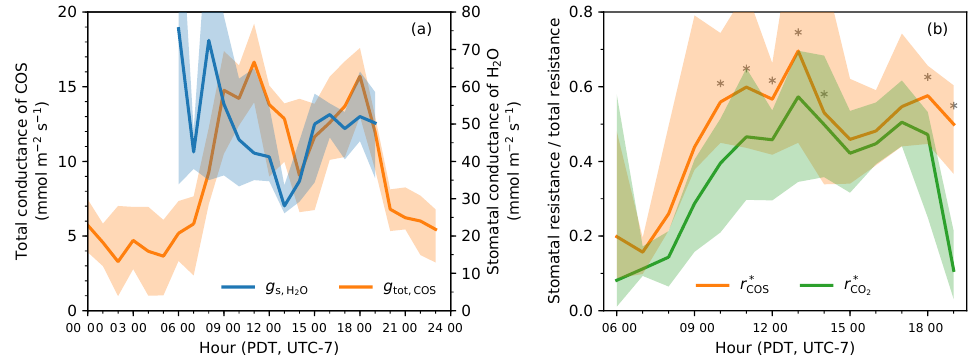
Figure 6. (a) Diurnal patterns of the stomatal conductance of water (blue, right y -axis) and the total conductance of COS (orange, left y -axis). Note that the two variables were on different scales for visual comparison. (b) Daytime patterns of the fraction of stomatal resistance in the total resistance for COS (orange) and for CO 2 (green). Similar to Fig. 3, in both panels solid curves indicate medians and shaded areas are between 25th and 75th percentiles, binned by the hour of the day. The asterisk markers in panel (b) indicate that the difference between r ∗ and r ∗ for that time of the day is significant at p < 0 . 05 level in a paired two-sample t CO 2